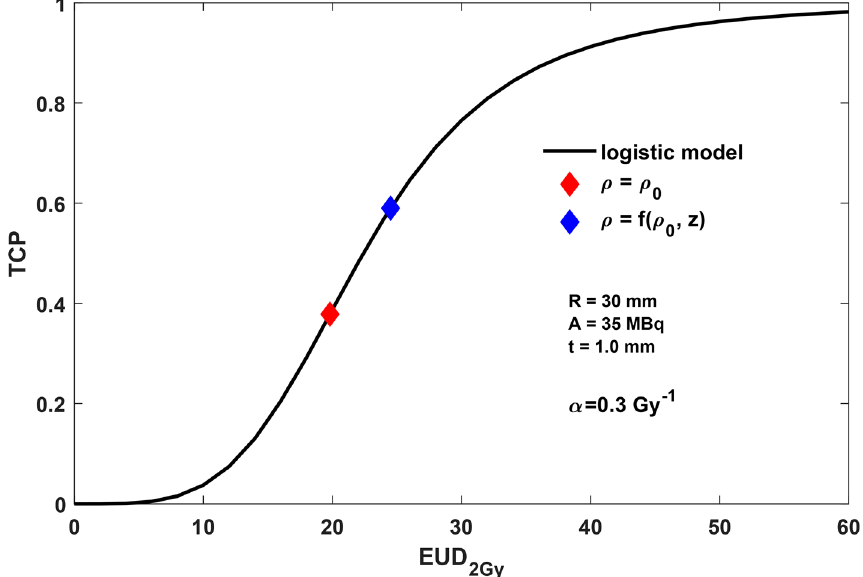
Figure 7. TCP based on logistic model (solid line) as a function of the EUD 2Gy . Estimated TCP value for R = 30 mm, A = 35 MBq and BAT-90 layer t = 1.0 mm in case of constant ρ (red marker) and linearly decreasing ρ (blue marker). The α is equal to 0.3 Gy −1